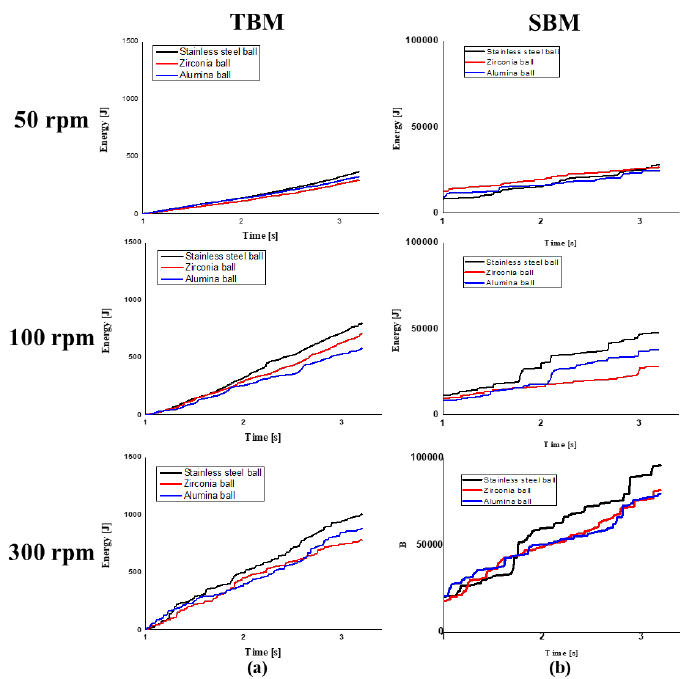
Figure 16. Milling energy spectra of 50, 100, 300 rpm in both mills ( a ) TBM, and ( b ) SBM by DEM simulation.